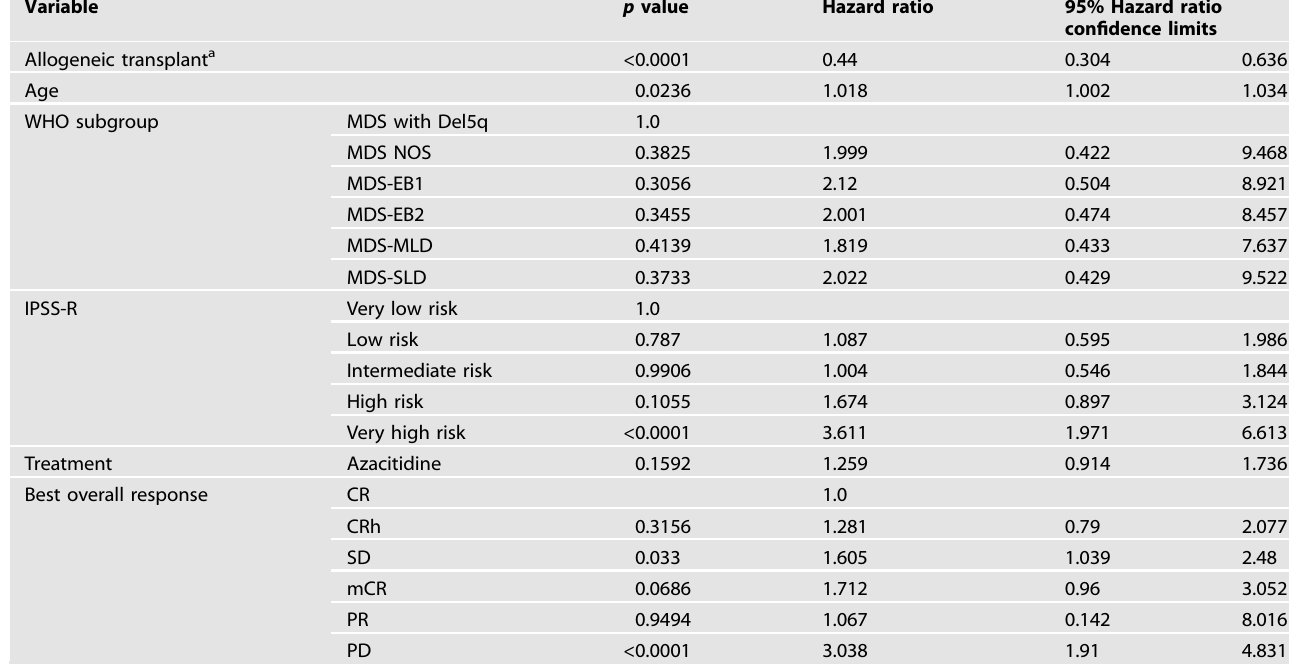
Table 3. Multivariate analysis for overall